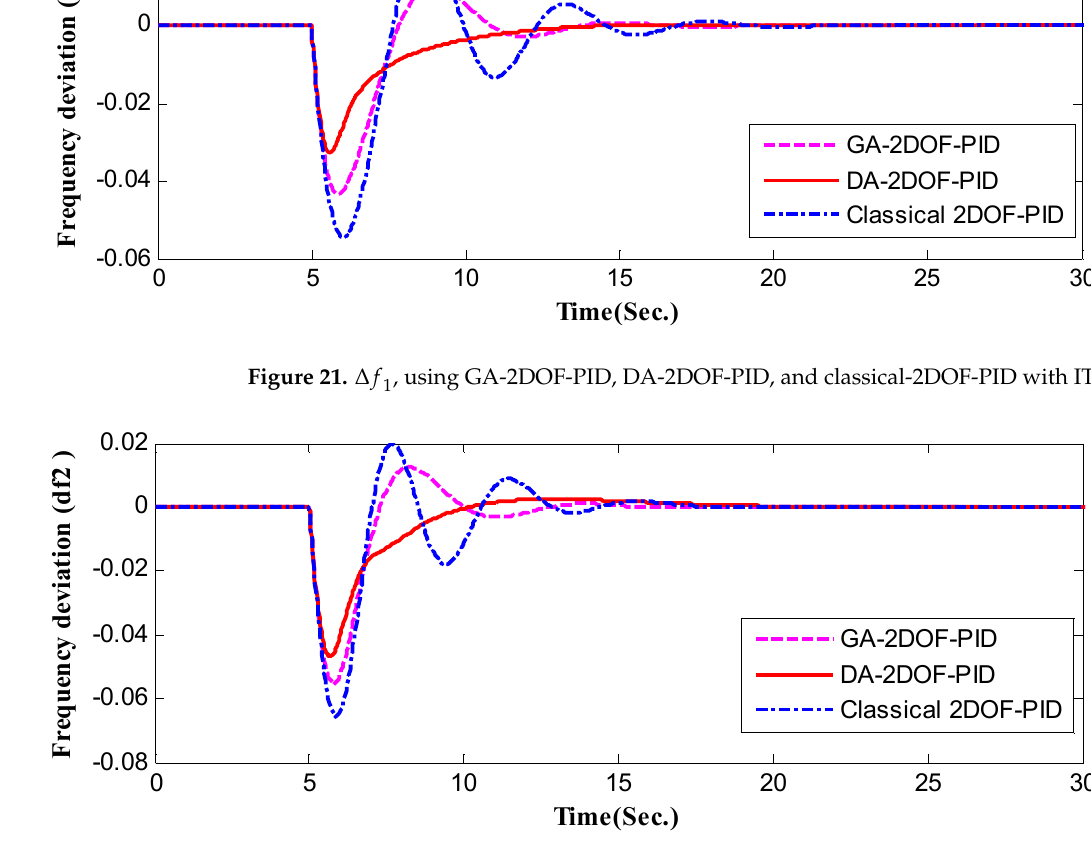
Figure 22. Δf (cid:2870) , using GA-2DOF-PID, DA-2DOF-PID, and classical-2DOF-PID with ITAE.